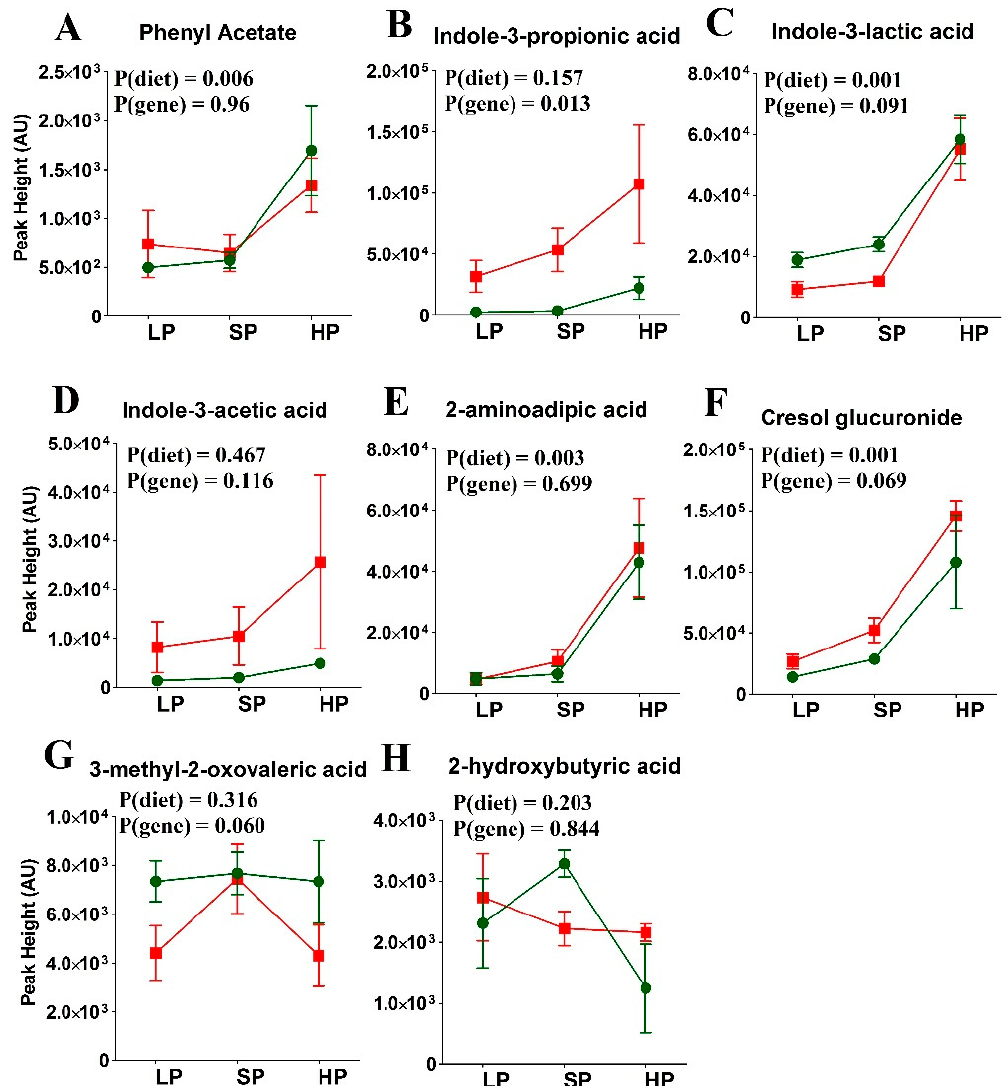
Figure 6. Abundance of amino acid-derived metabolites in the plasma of SLC6A19 ko (red) and wt (green) mice on diets with low (LP), standard (SP), or high protein (HP) contents in the fasted state ( n = 5). Amino acid-derived metabolites: (A) Phenyl acetate, (B) Indole-3-propionic acid, (C) Indole-3-lactic acid, (D) Indole-3-acetic acid, (E) 2-aminoadipic acid, (F) Cresol glucuronide, (G) 3-methyl-2-oxovaleric acid and (H) 2-hydroxybutyric acid. No significant differences ( p -value of < 0.05) were observed between the genotypes. The error bars represent x ± SEM ( n = 5 per group). p -values were calculated by ANOVA comparing within-group and between-group variances of the diet effects (diet) and genotype effects (gene).